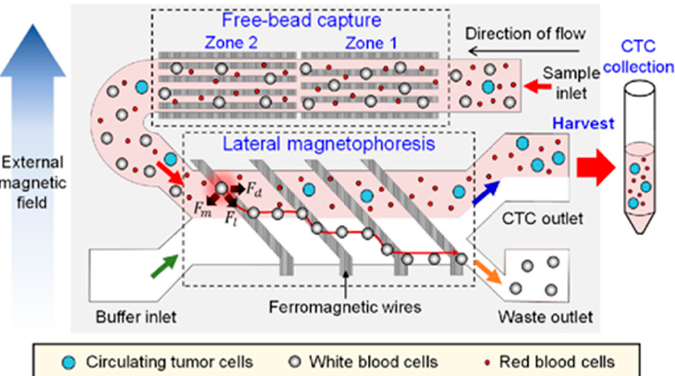
Figure 10. Negative enrichment of CTCs using ferromagnetic wires. In Zone 1 and Zone 2, unbound beads are eliminated from the rest of the sample due to low Drag forces on magnetic beads. Then, immunomagnetically labeled cells are removed from the main fluidic stream via ferromagnetic wires under external magnetic field. Reproduced with permission [86]. Copyright 2019 MDPI. Table 2. Summary of the recent magnetophoretic positive and negative enrichment of CTCs.